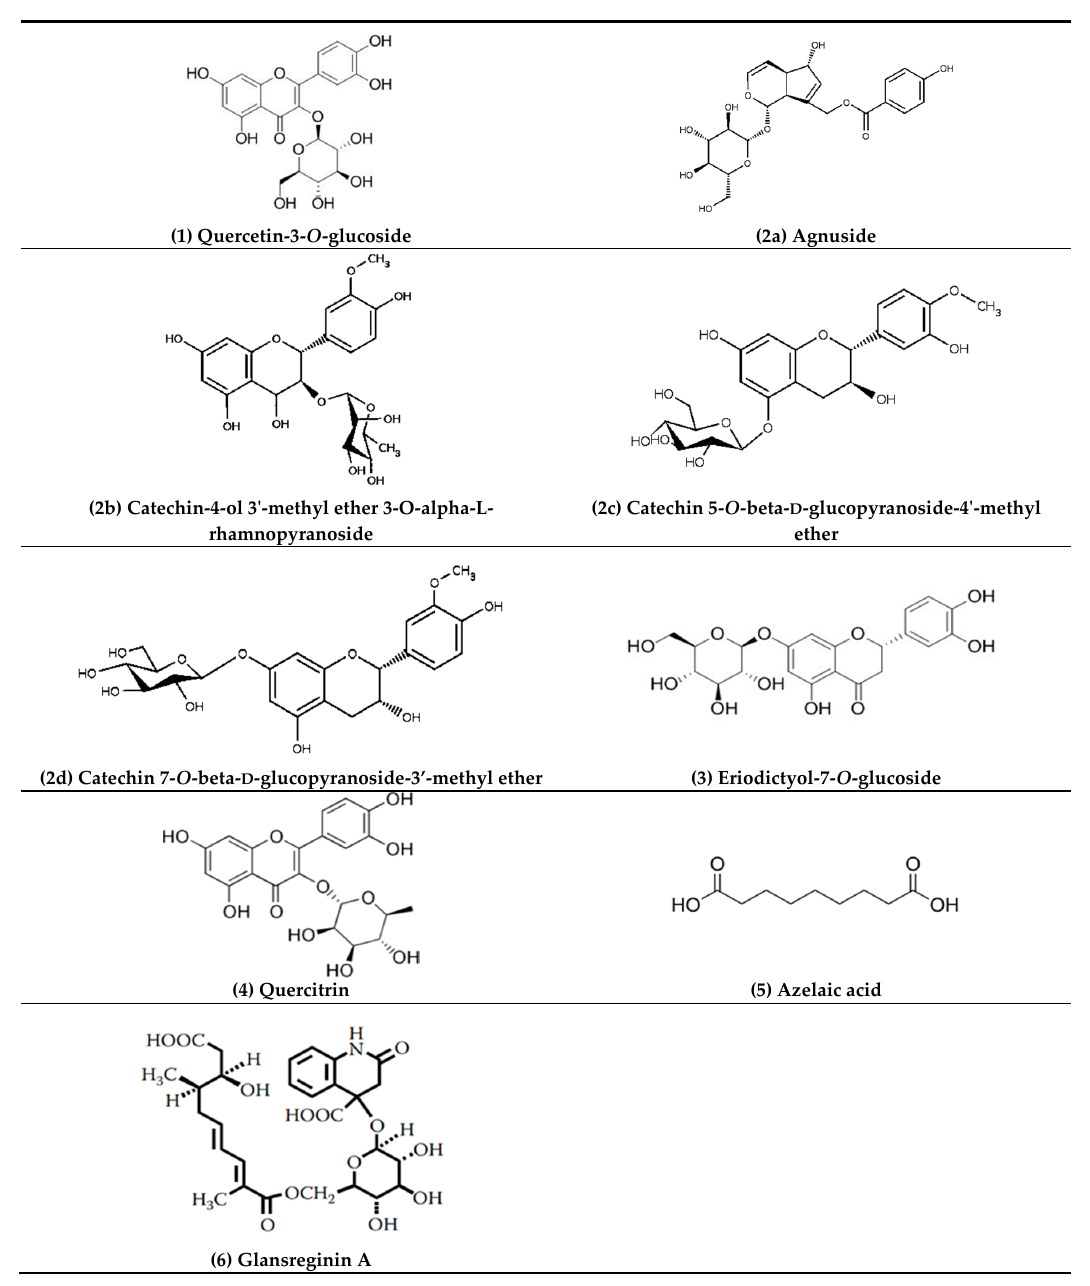
Figure 6. Chemical structures of tentative compounds from black walnut (Mystry).